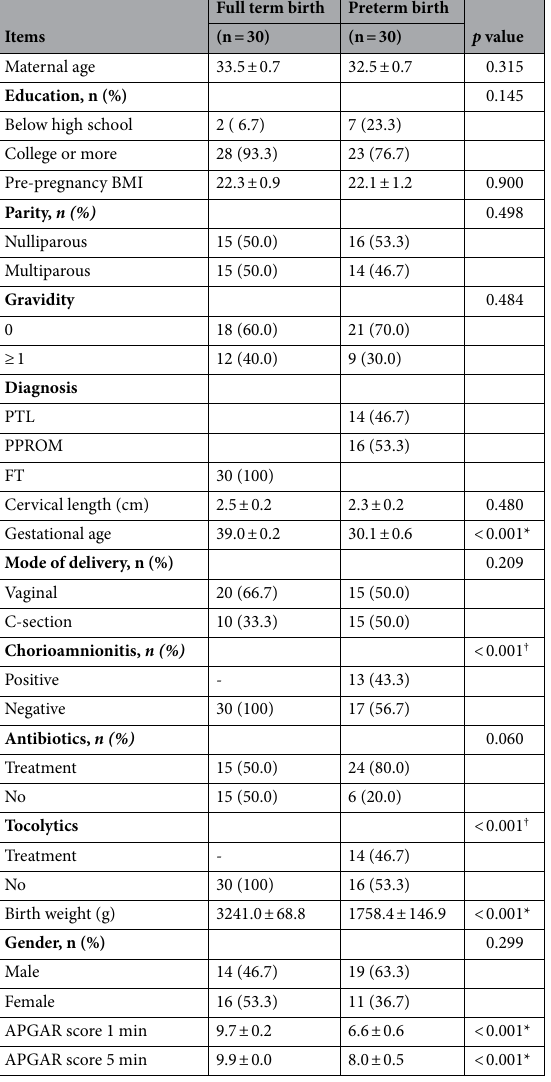
Table 1. Clinical characteristics of subjects used for qRT-PCR analysis. Data were presented as mean ± SE. *Student’s t-test, p < 0.05; † χ 2 test, p < 0.05. BMI body mass index, PTL Preterm labor, pPROM Preterm premature rupture of membrane, FT Full